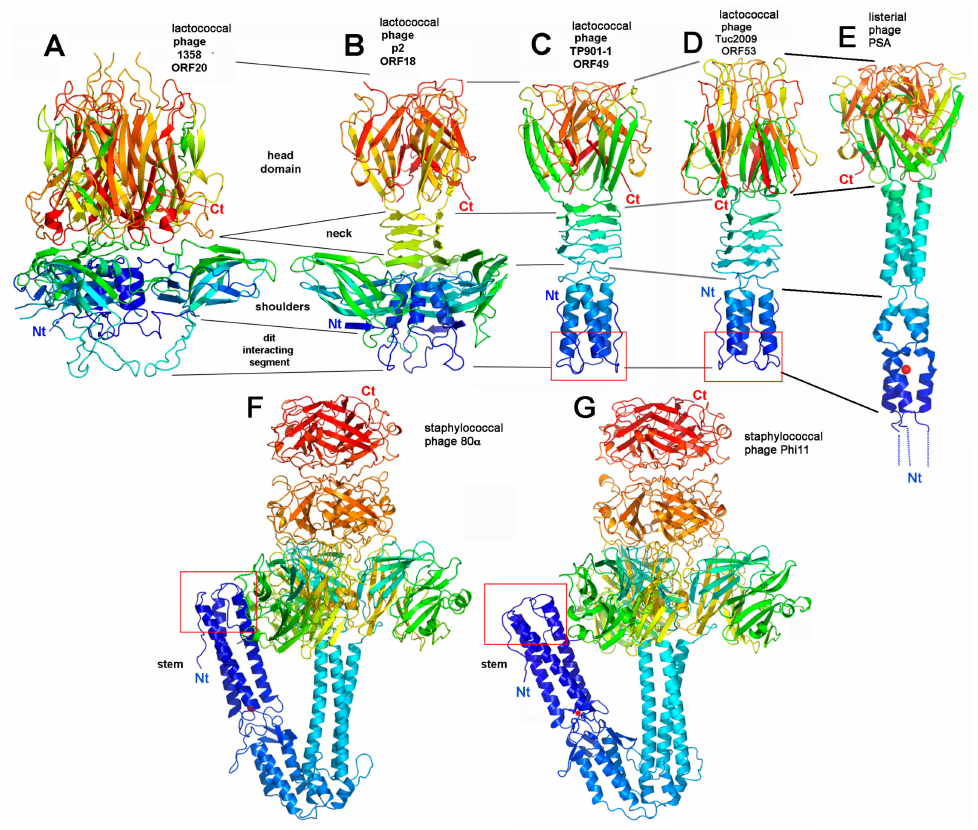
Figure 3. X-ray structures of RBPs from siphophages binding to host cell wall saccharidic receptors. ( A ) Lactococcal phage 1358 [55]; ( B ) Lactococcal phage p2 [51]; ( C ) Lactococcal phage TP901-1 [53]; ( D ) Lactococcal phage Tuc2009 [54]; ( E ) Receptor-binding domain and stem of listerial phage PSA [13]; ( F ) Staphylococcal phage 80 α [15]; ( G ) Staphylococcal phage φ 11 [57]. The various domains